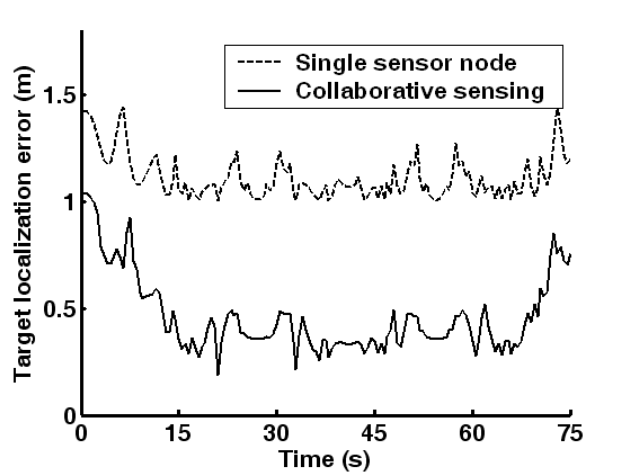
Figure 9. Comparison of target localization error with collaborative sensing and single sensor